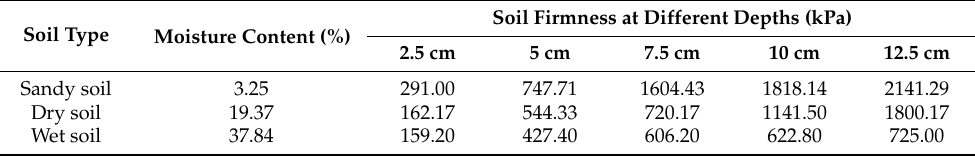
Table 1. Physical parameters of the experimental soil.